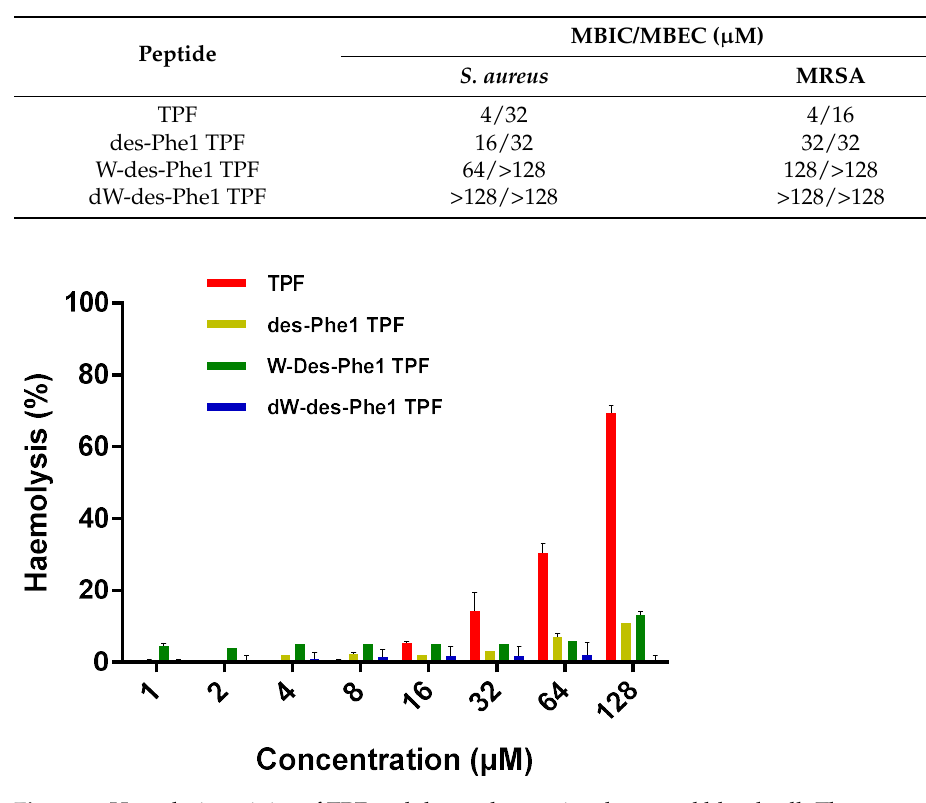
Figure 9. Hemolytic activity of TPF and the analog against horse red blood cell. The percentage of hemolysis was calculated with the absorbance at 570 nm, compared with PBS-treated red blood cells. The error bar represents SD of five replicates.